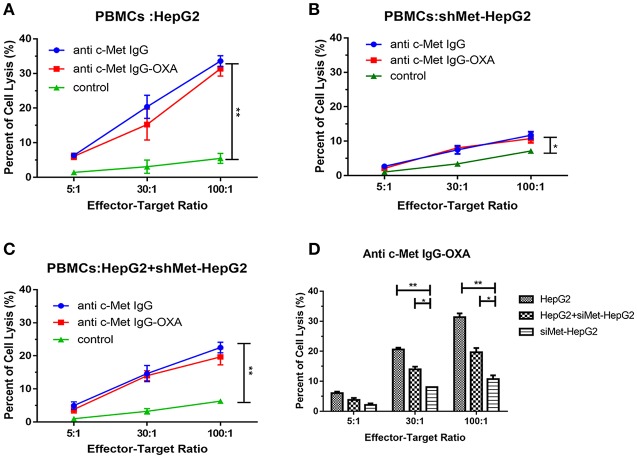
Antibody-dependent cell-mediated cytotoxicity. PBMC-mediated lysis of HepG2 and shMet-HepG2 cells was determined using a standard LDH Cytotoxicity Assay Kit in the presence of Fc fragment from the conjugates and humanized antibody. PBMCs as effector cells react with the HepG2 (A), shMet-HepG2 (B), or a mixture of HepG2+ shMet-HepG2 (C) target cells at a ratio of 5:1, 30:1, and 100:1 co-incubated with anti-c-Met IgG or anti-c-Met IgG-OXA. The humanized antibody and conjugates significantly induced ADCC in comparison to the control at all E:T ratios in HepG2 cells. A significant decrease in ADCC activity was observed in shMet-HepG2 cells with c-Met knockdown. Similar attenuation effects of ADCC could also be found in mixed HepG2+shMet-HepG2 cells. (D) Comparative analysis of the capacity of PBMC-mediated lysis in the presence of anti-c-Met IgG-OXA. No significant ADCC was stimulated in shMet-HepG2 cells. In the presence of the conjugate, PBMCs killed more HepG2 cells. Data represent three experiments performed in triplicate.*P < 0.05 and **P < 0.01.